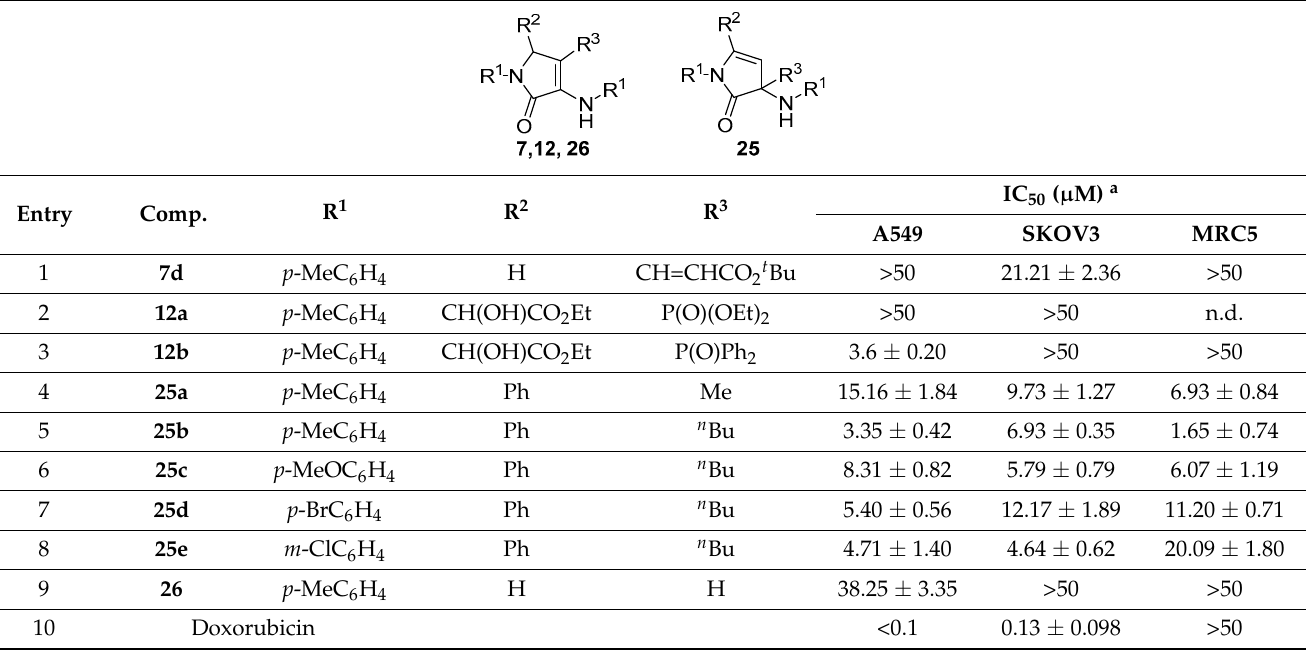
Table 1. Selected antiproliferative activities of γ -lactam derivatives 7 , 12 , 25 , and 26 against lung and ovarian cancer cell lines.